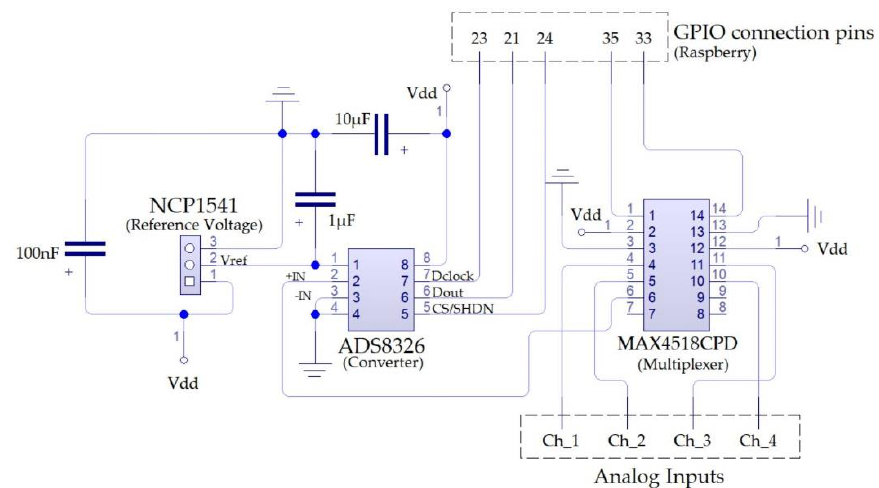
Figure 1. Analog to digital converter (ADC) electrical wiring diagram.